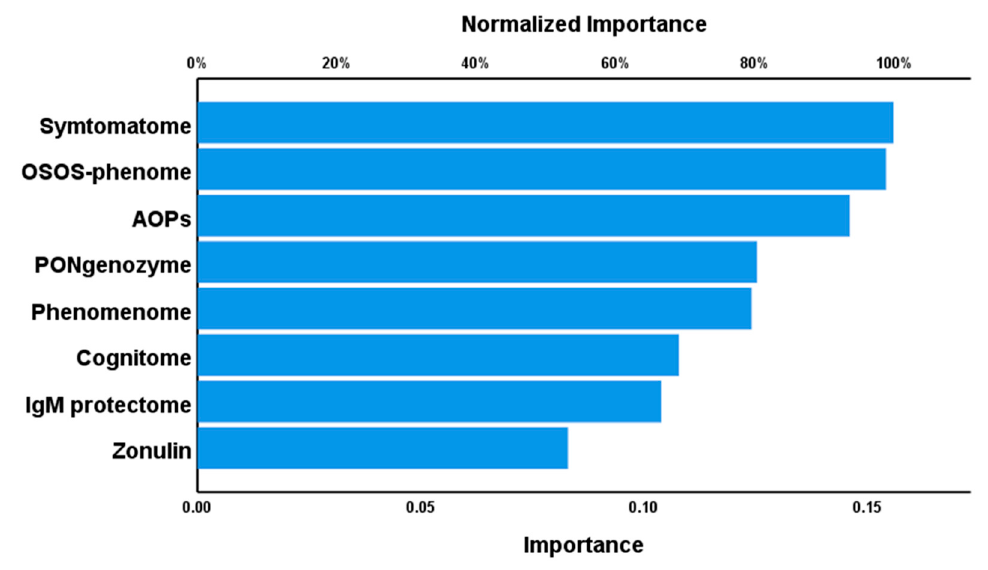
Figure 5. Results of neural networks showing the importance chart. Shown are the (relative) importance of the latent variable scores reflecting IgM to zonulin, a combination of CMPAase activity and the Q192R PON1 genotype (PONgenozyme), natural IgM to oxidative specific epitopes (IgM protectome); AOPs: advanced outcome pathways; OSOS-phenome: overall severity of schizophrenia score which combines the AOP + cognitome + symptomatome scores.